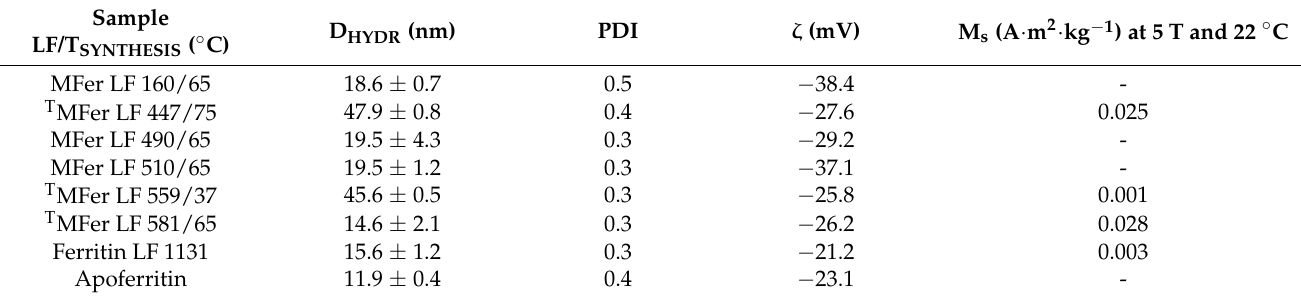
Table 1. Summary of measured integral parameters for MFer